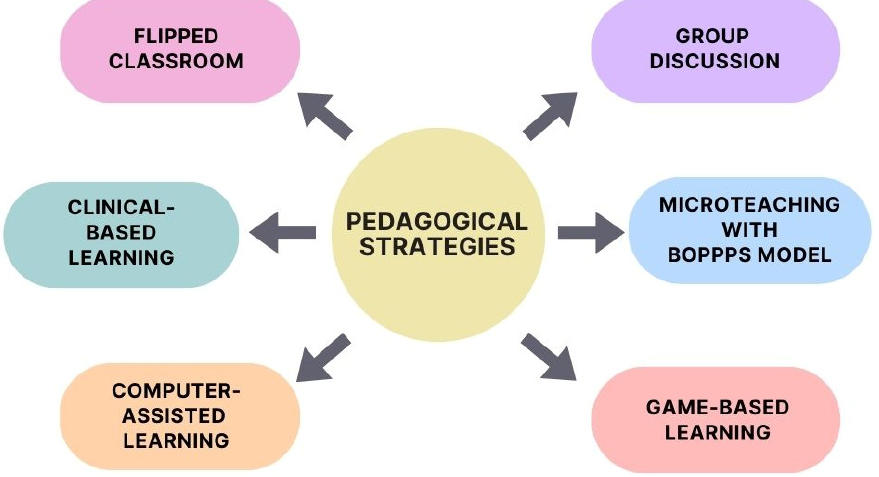
Figure 2. Different innovative pedagogical strategies in dental materials science education.